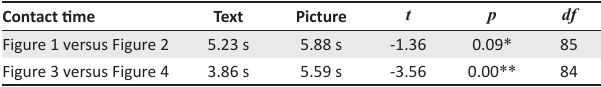
TABLE 7: Contact time results: Text versus pictures. Contact time Text Picture Figure 1 versus Figure